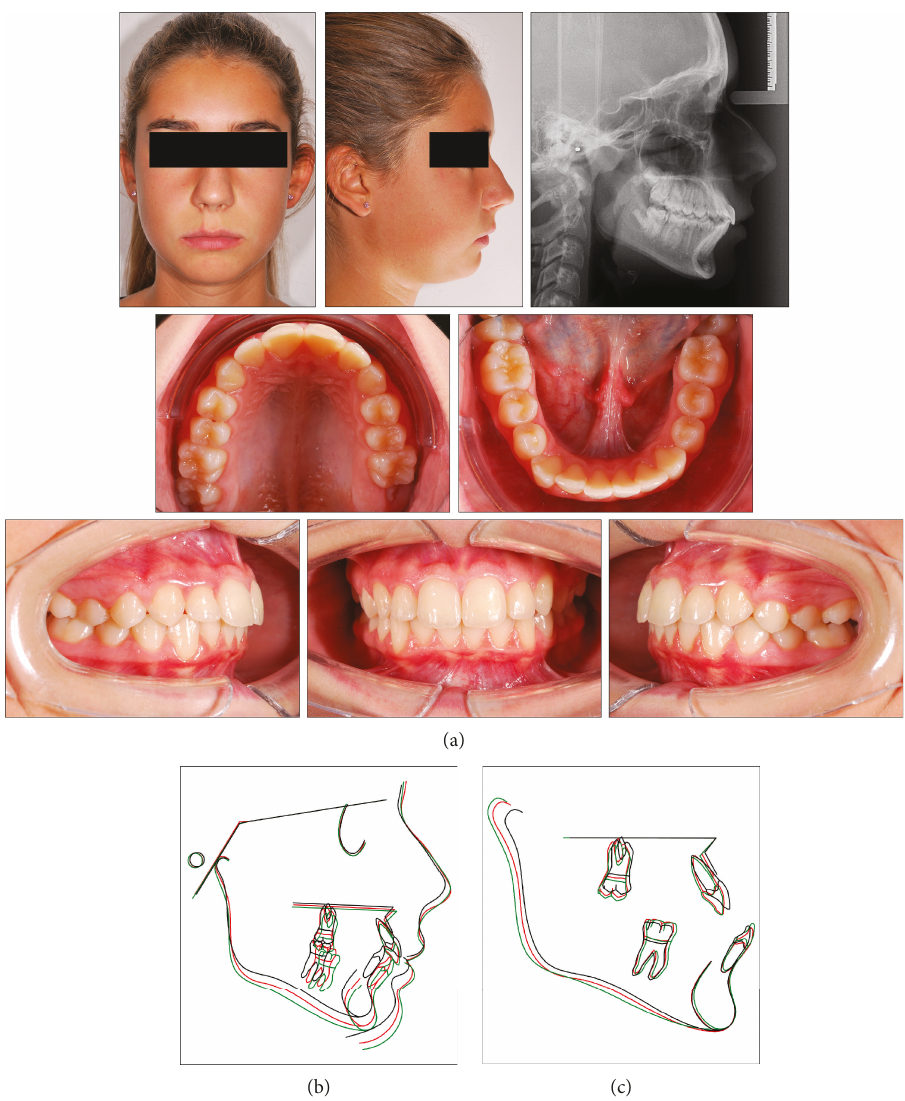
Figure 9: Case 2. (a) Patient after 16 months of follow-up when she was 13 years and 10 months old. (b) Superimposition of pretreatment (black), posttreatment (red), and follow-up (green) cephalometric tracings on stable structures of the anterior cranial base. (c) Regional superimposition of cephalometric tracings on the maxilla and